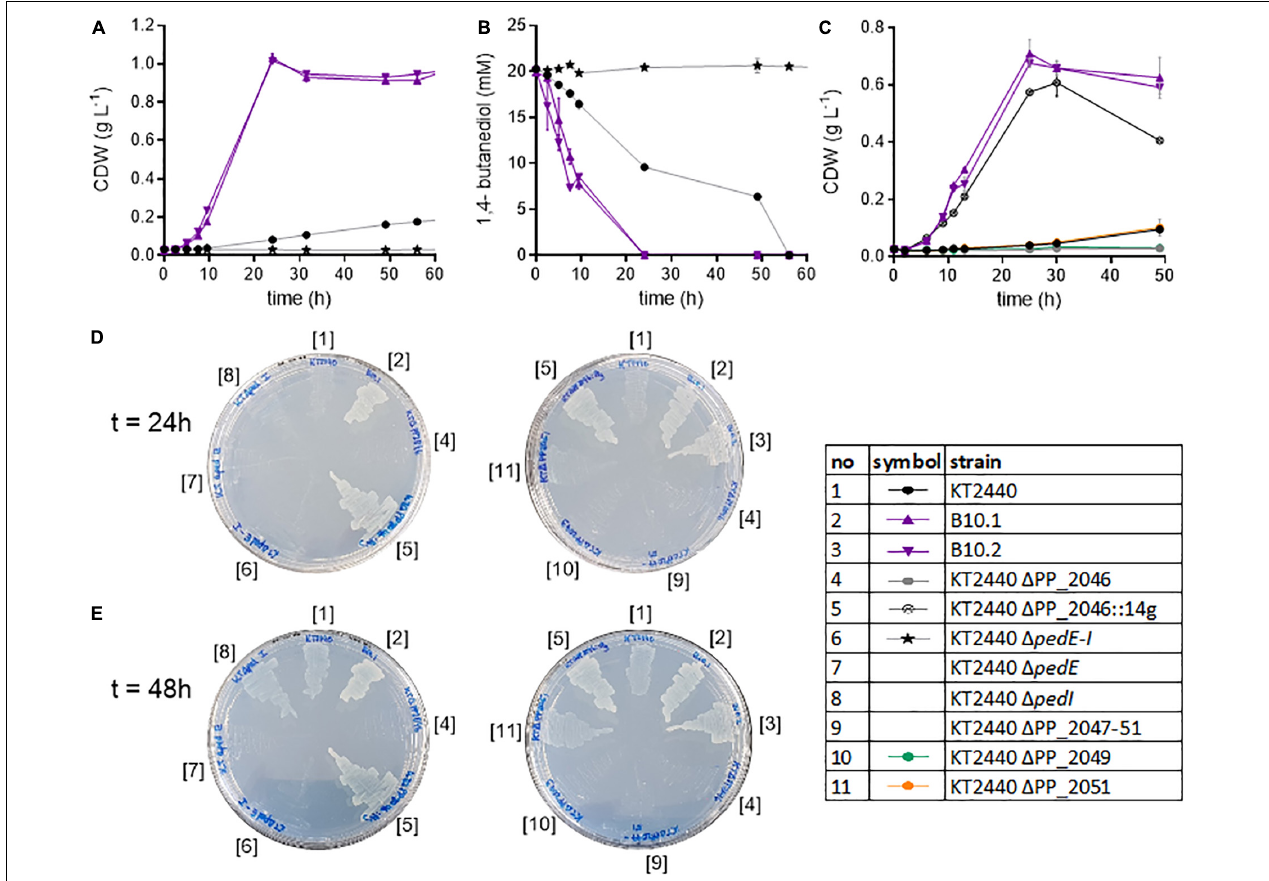
FIGURE 4 | Analysis of knockout strains of P. putida KT2440. Biomass growth (A) and 1,4-butanediol concentrations (B) of the wildtype, evolved strains and the (cid:49) pedE-I knockout cultivated in shake flasks in MSM with 20 mM 1,4-butanediol. Growth of selected strains on 20 mM 4-hydroxybutyrate (C) . Growth of selected strains on MSM agar plates with 20 mM 1,4-butanediol after 24 h (D) and 48 h (E) . Strain numbers next to the plates correspond to full strain names listed in Table 1 . The contrast of the images was increased by 20% to improve visibility. Error bars indicate the deviation of the mean ( n =